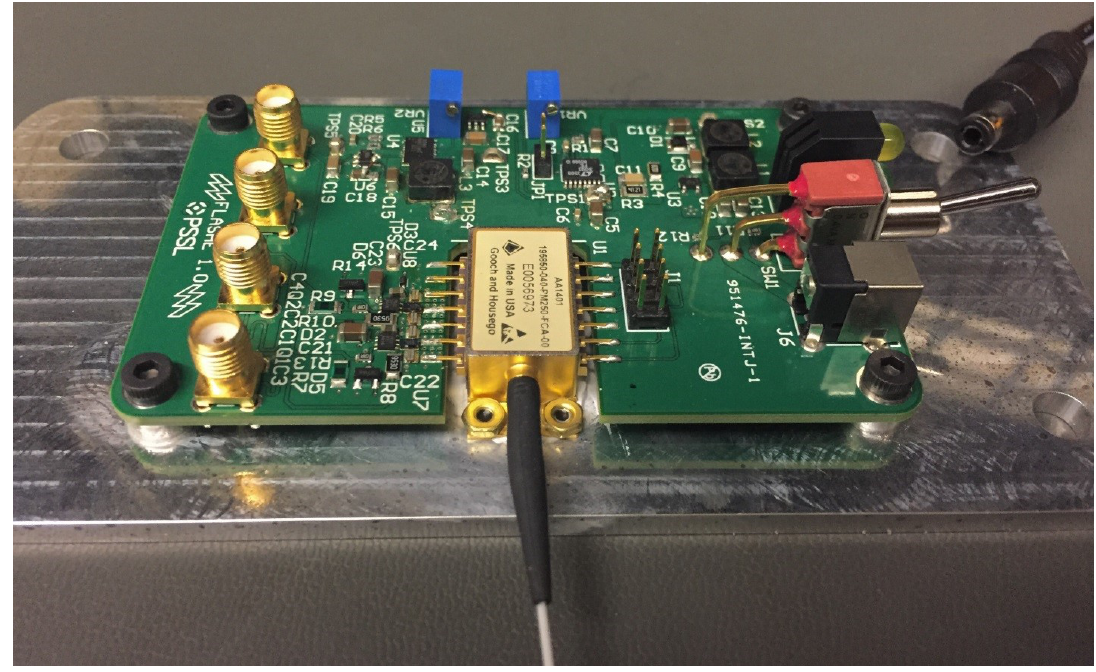
Figure 6. FLASHE 1.0 current driver module with 1531 nm laser for in-lab